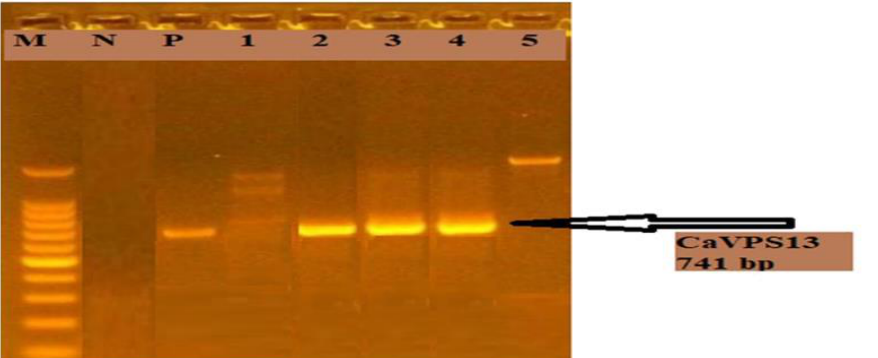
Fig. 6. Agarose gel electrophoresis of 741 bp specific PCR product for CaVP13 gene for candida spp. using 1.5% agarose gel at 90V for 1hr. in 1x TBE buffer, and visualized under transilluminator UV after staining by ethidium bromide. Lane M: 100 bp . DNA ladder, lane (2, 3, 4): positive result, lane N: negative control and lane P: positive control.